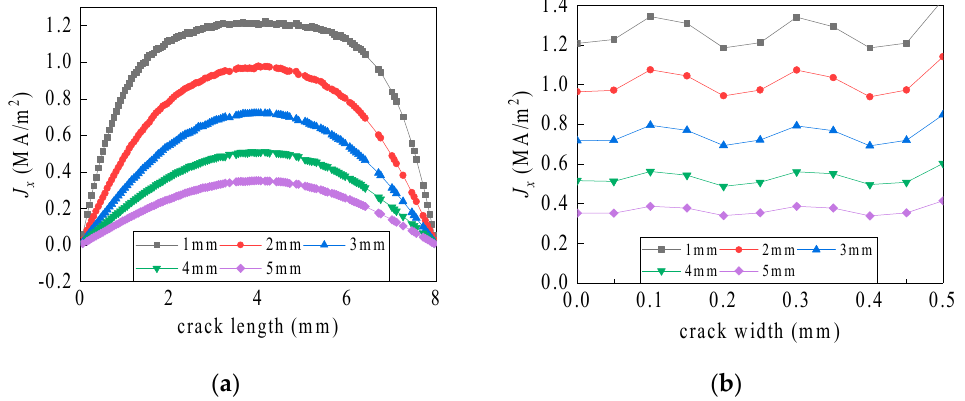
Figure 10. Current density distribution along the axis of symmetry on the crack bottom. ( a ) Line c and ( b ) line d.